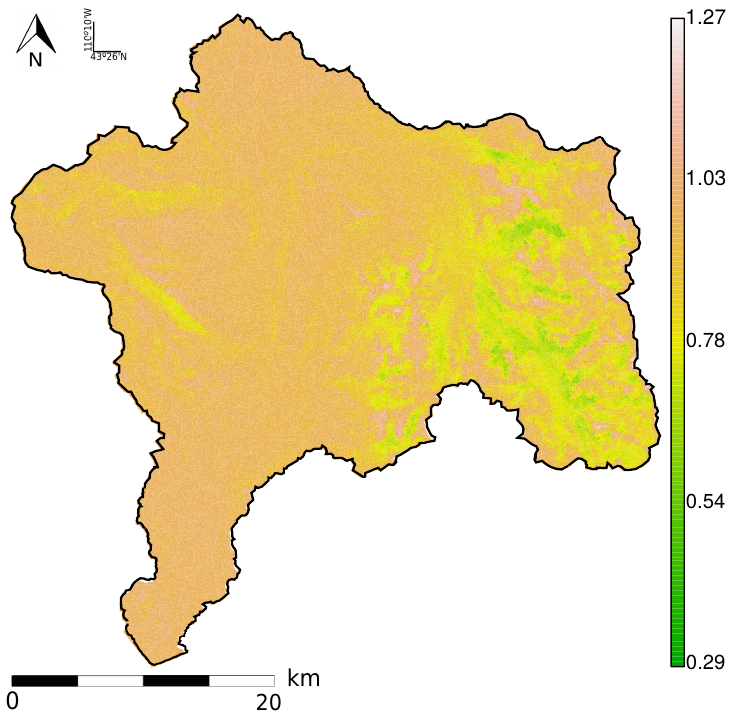
Figure 6. Sky view fraction fvs as calculated from the algorithm presented in Section